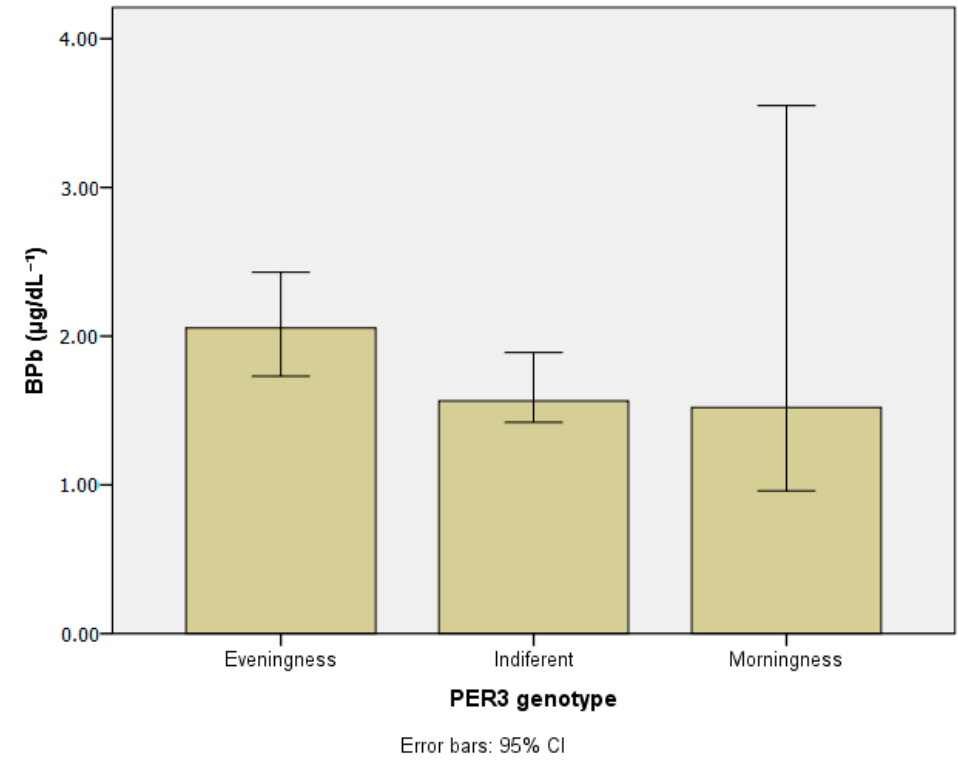
Figure 3. Lead in blood ( μ g/dL − 1 ) according to PER3 gene VNTR polymorphisms.